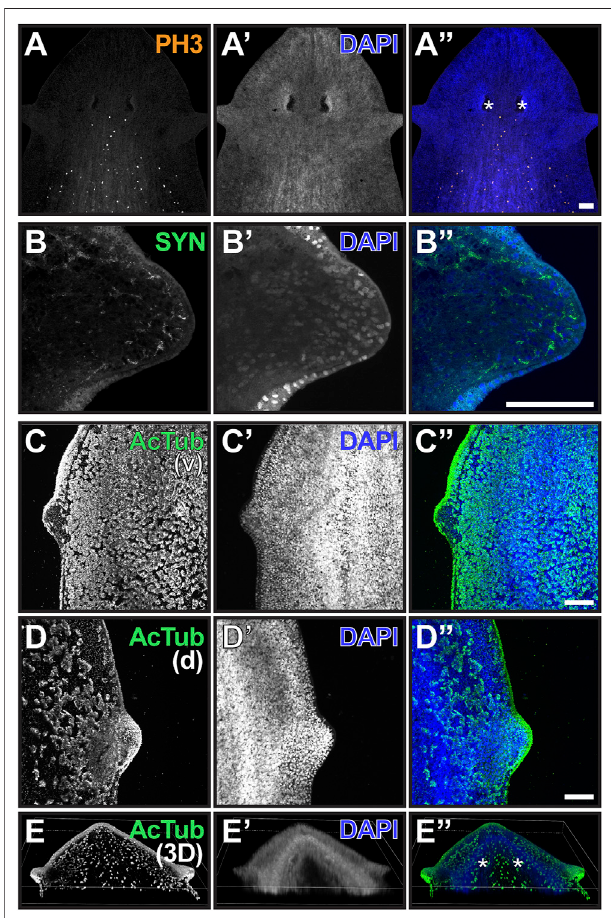
FIGURE 2 | The auricle is largely composed of neurons and ciliated epithelia. (A – D) Maximum intensity projection of confocal z-stack images of whole-mount samples analyzed by phospho-Histone H3 Ser10 [PH3; (A and A ” ) ], synapsin [SYN; (B and B ” ) ], and acetylated alpha-tubulin [acTub; (C and D) and (C ” and D ” ) ] immuno fl uorescence. Ventral (v) and dorsal (d) viewsofciliatedepitheliumareshownin (CandD) ,respectively.DNAstaining using DAPI reveals nuclei in (A ’– D ’ ) ; blue in (A ”– D ” ) and is used to visualize total cellular distribution. Scale bars (cid:2) 0.1 mm. (E) Three-dimensional reconstruction of whole-mount sample analyzed as in (D) illustrates distribution of ciliated cells in the head of G. dorotocephala . Position of photoreceptors is marked by asterisks in (A ” ,E ” )